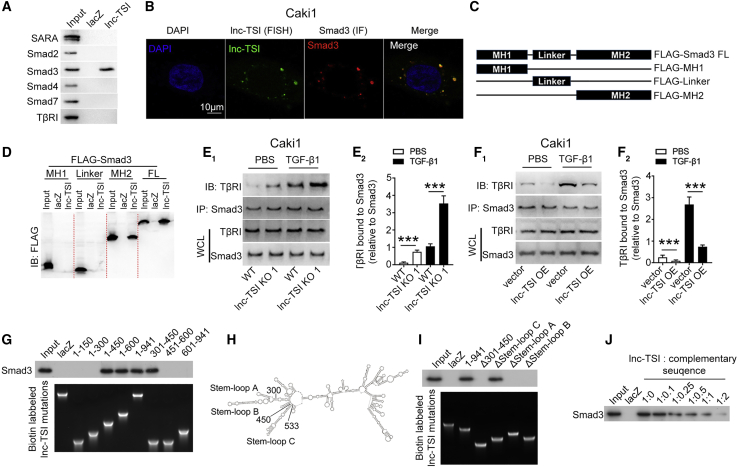
lnc-TSI Bound to Smad3 and Blocked the Interaction between TβRI and Smad3 in ccRCC Cells(A) lnc-TSI bound to Smad3 in Caki-1 cell lysates as shown by western blot after RNA pull-down. (B) Confocal images showed the colocalization of lnc-TSI and Smad3 in Caki-1 cells stimulated with TGF-β1 (10 ng/mL) for 24 h. (C) To test the binding domain of Smad3 with lnc-TSI, deleted mutants of Smad3 fragments were constructed and labeled by FLAG. (D) Western blot after RNA pull-down showed that lnc-TSI interacted with the MH2 domain and the full length of Smad3 in Caki-1 cell lysates. (E) Cell lysates of Caki-1 cells with lnc-TSI knockout or control were immunoprecipitated (IP) with anti-Smad3 antibody followed by immunoblotting (IB). Representative images (E1) and data analysis (E2) showed that knockout of lnc-TSI increased the interaction between Smad3 and TβRI. Whole-cell lysates (WCLs) were used as controls. (F) Representative images (F1) and data analysis (F2) showed that overexpressing lnc-TSI decreased the interaction of Smad3 with TβRI. (G) RNA pull-down showing the interaction of lnc-TSI mutants with Smad3 in vitro. (H) According to the RNAfold package, lnc-TSI was predicted to form two stem-loop structures with nucleotides (nt) sequence 301–450. (I) RNA pull-down indicated that deletion mutations of either stem-loop A or stem-loop B abolished the binding capacity of lnc-TSI to Smad3. (J) RNA pull-down indicated that preincubating lnc-TSI with its complementary sequence at different molar ratios inhibited the interaction of lnc-TSI with Smad3 in vitro. Data are expressed as means ± SD of three independent experiments. ∗∗∗p < 0.001.